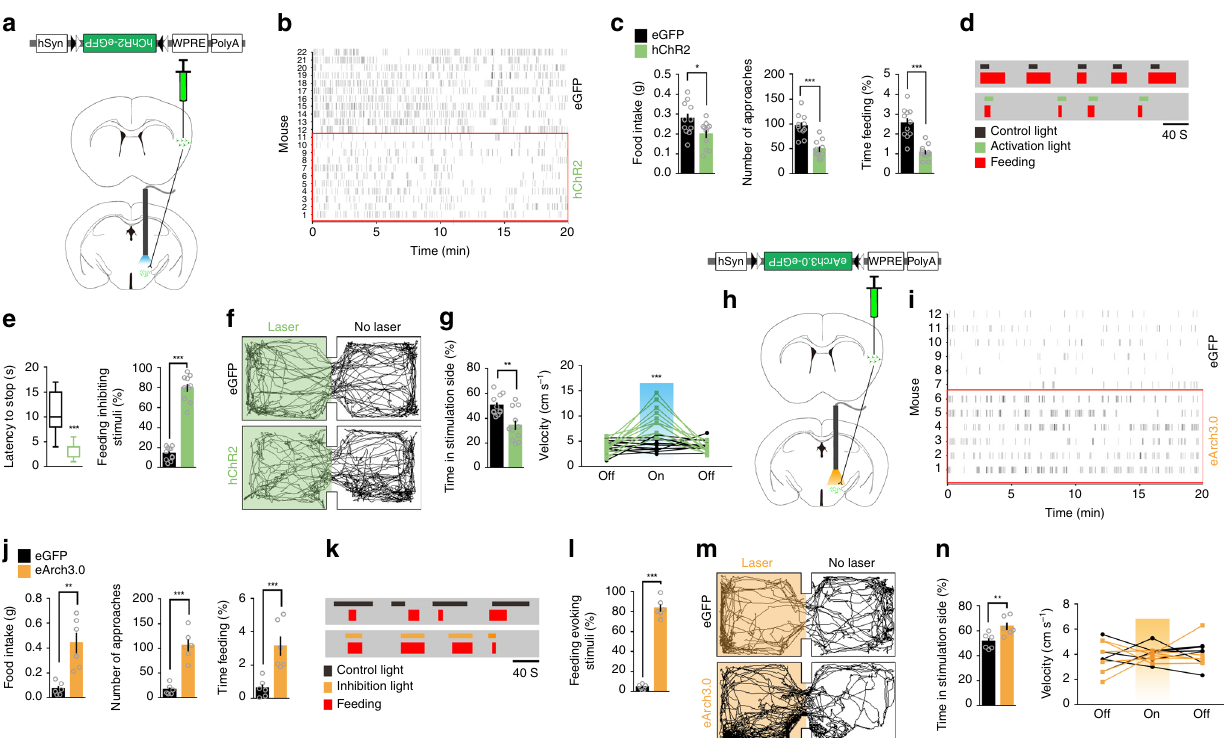
Fig. 7 Right aIC CamKII -to-LH projections mediate feeding and avoidance behaviors. a Diagrams illustrating Camk2a-Cre mice injected with hChR2-eGFP in the right aIC and photostimulated in the LH. b Raster plot of approaches to food in 24-h-fasted mice with the right aIC CamKII -to-LH terminals being activated. c Activation of the right aIC CamKII -to-LH terminals inhibits food intake in 24-h-fasted mice. Total food consumption, number of approaches and the percentage of feeding time were measured ( n = 11 mice per group). d Raster plots showing feeding processes by one 24-h-fasted animal in its home cage. Activation light or control light was triggered after feeding began. e Latency to stop feeding (left) in response to light activation and the percentage of light stimuli that inhibits feeding ( n = 11 mice per group). f Representative locomotor trace of a mouse with the right aIC CamKII neurons expressing eGFP or hChR2 and the right LH receiving 20-Hz photostimulation in the laser compartment. g Percentage of time spent in the photostimulation side (left) and locomotor activity in laser or no laser sides (right) ( n = 11 mice per group). h Diagrams illustrating Camk2a-Cre mice with eArch3.0-eGFP injected in the right aIC and photostimulation in the right LH. i Raster plot of feeding approach in fed mice with the right aIC CamKII -to-LH terminals being photoinhibited. j Total food consumption, number of approaches to food, and the percentage of feeding time were measured ( n = 6 mice per group). k Raster plots showing feeding processes by one fed animal in its home cage. Inhibition light or control light was triggered randomly. l The percentage of light stimulation that induces feeding ( n = 6 mice per group). m Representative locomotor trace of a mouse with the right aIC CamKII -to-LH terminals expressing eGFP or eArch3.0 and receiving photoinhibition in the laser compartment. n Percentage of time spent in the photoinhibition side and locomotor activity in laser or no laser sides ( n = 6 mice per group). Two-tailed unpaired t test, * P < 0.05; ** P < 0.01; *** P < 0.005. Data are presented as means± SEM. Source data are provided as a Source Data fi unpaired t test, time in stimulation side, t 20 = 3.493, P = 0.0023; t 8 = 2.803, P = 0.0230; number of approach, t 8 = 3.153, P = 0.0275; time feeding, t 8 = 4.786, P = 0.0014, Supplementary velocity, 1st light off step, t 20 = 0.5406, P = 0.5948, 1st light on Fig. 12c) and induced place avoidance (Two-tailed unpaired t step, t 20 = 5.778, P < 0.0001, 2nd light off step, t 20 = 0.7825, P = 0.3862, Fig. 7m, n), while having no effects on drinking test, time in stimulation side, t 8 = 4.329, P = 0.025; velocity, 1st behavior (Two-tailed unpaired t test, water intake, t 10 = 1.253, light off step, t 8 = 0.8011, P = 0.4462 1st light on step, t 8 = 8.526, P < 0.0001, 2nd light off step, t 8 = 1.824, P = 0.1056, Supplemen- P = 0.2386; number of licks, t 10 = 1.949, P = 0.0798; time tary Fig. 12d, e), while having no effects on drinking behavior drinking, t 10 = 0.2572, P = 0.8023, Supplementary Fig. 13b). (Two-tailed unpaired t test, water intake, t 8 = 0.7801, P = 0.4578; number of licks, t 8 = 1.206, P = 0.2623; time drinking, t 8 = 0.3376, P = 0.7443, Supplementary Fig. 12f), consistent with